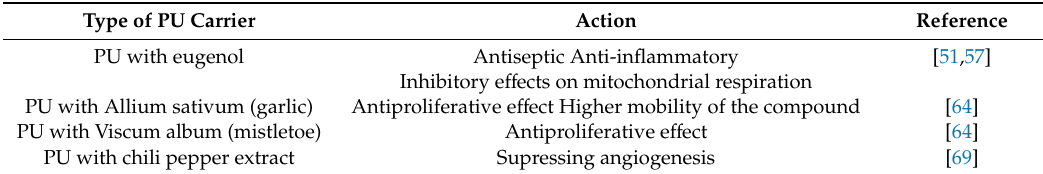
Table 2. PUcarriers with vegetable